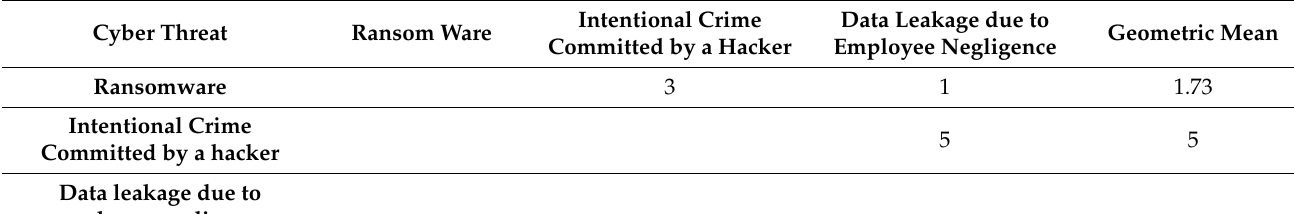
Table 8. Cyber threats and determining their significance (own resource).